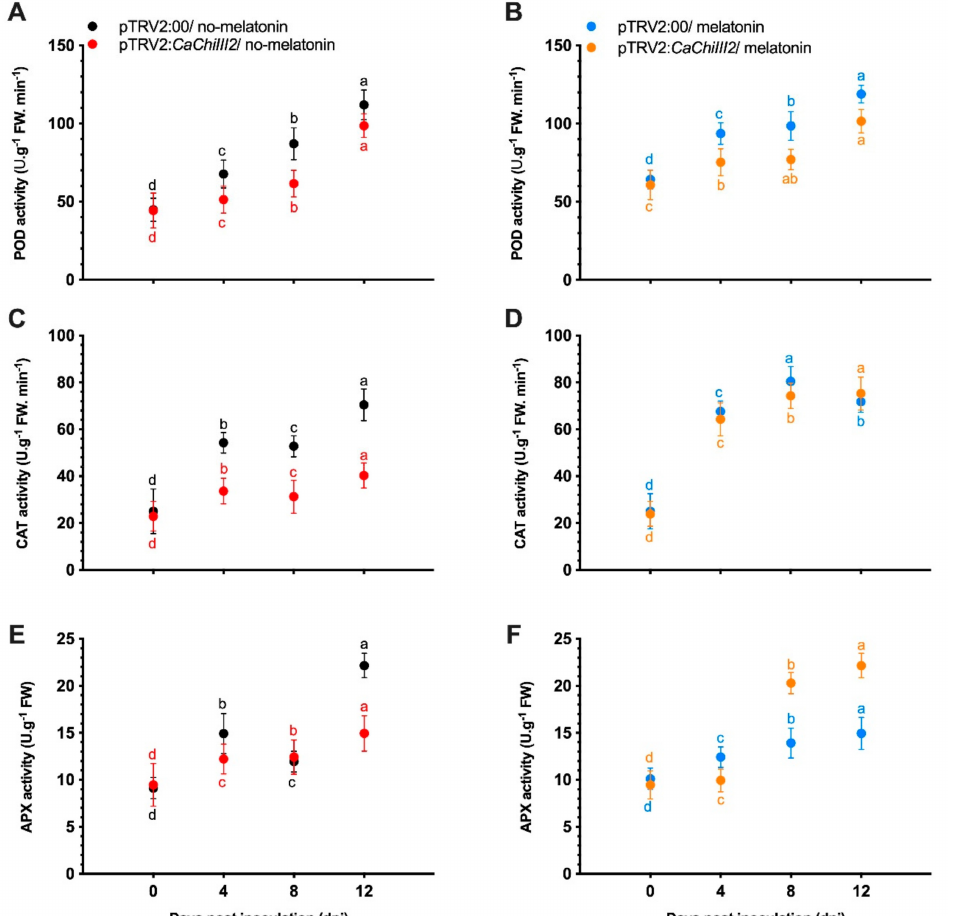
Figure 8. Effect of CaChiIII2 knockdown and exogenous melatonin treatment on antioxidant enzyme activities during C. gloeosporioides infection in pepper. ( A ) POD activities without melatonin pretreatment in pTRV2:00 and pTRV2: CaChiIII2 , ( B ) 100 µ M melatonin pretreated, ( C ) CAT activities without melatonin pretreatment in pTRV2:00 and pTRV2: CaChiIII2 , ( D ) 100 µ M melatonin pretreated, ( E ) APX activities without melatonin pretreatment in pTRV2:00 and pTRV2: CaChiIII2 , ( F ) 100 µ M melatonin pretreated. Mean values ± SDs of five replications are provided. Lower case letters (a–d) respective differences at p ≤ 0.05 with the DMR